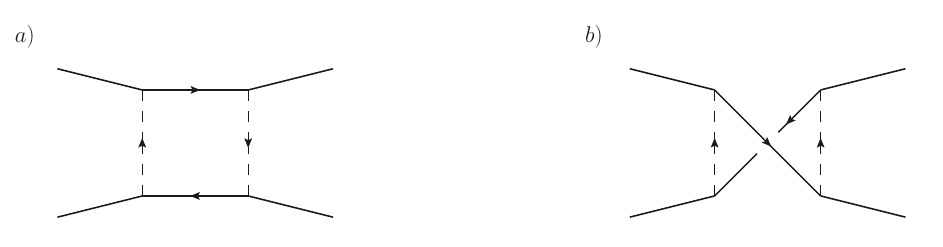
Figure 7 . One-loop diagrams for the matching of the dimension-6 and dimension-8 operators in the